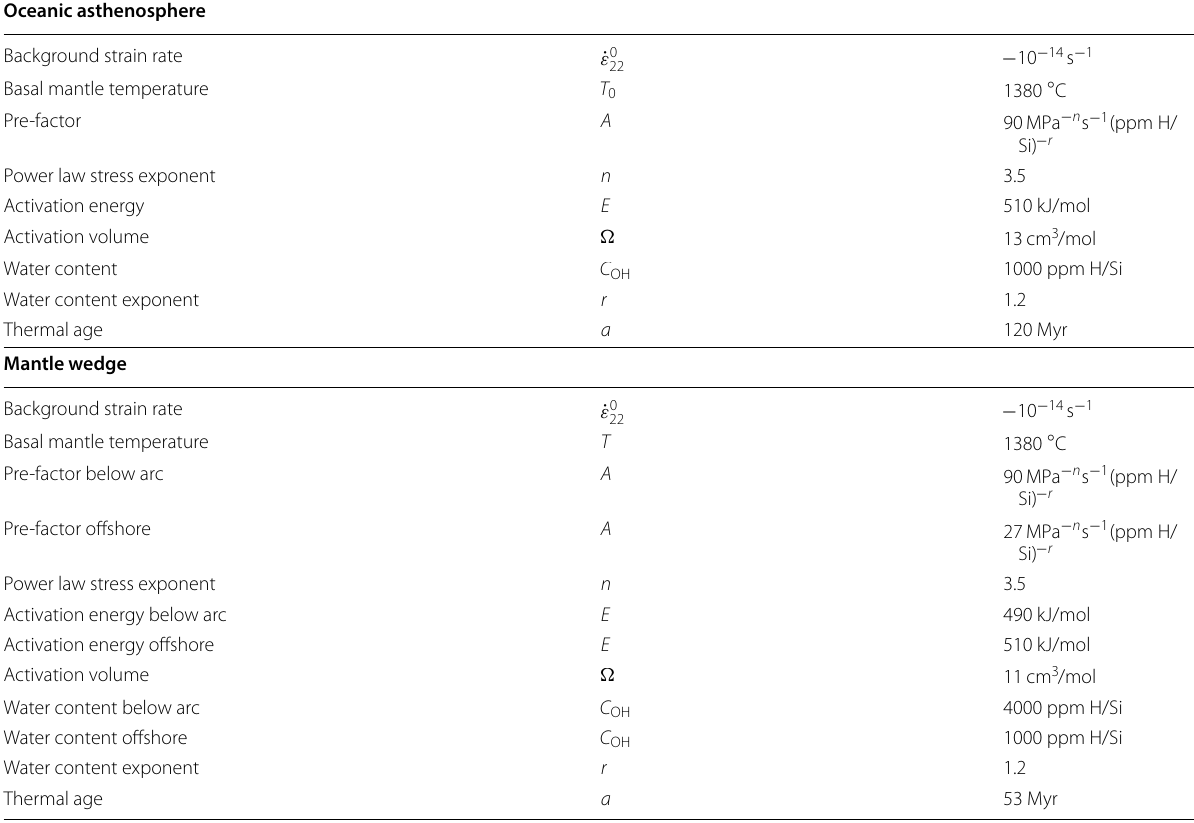
Table 2 Summary of the physical parameters for viscoelastic